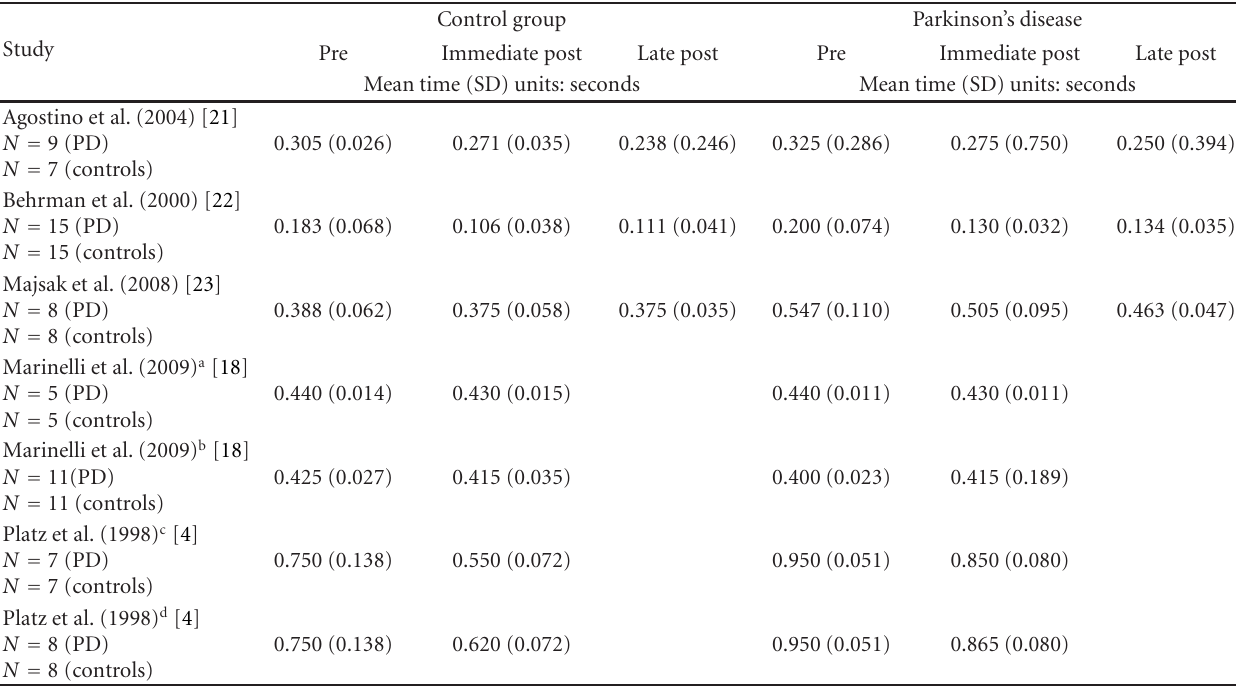
Table 3: Descriptive statistics of studies of upper lime reach task.